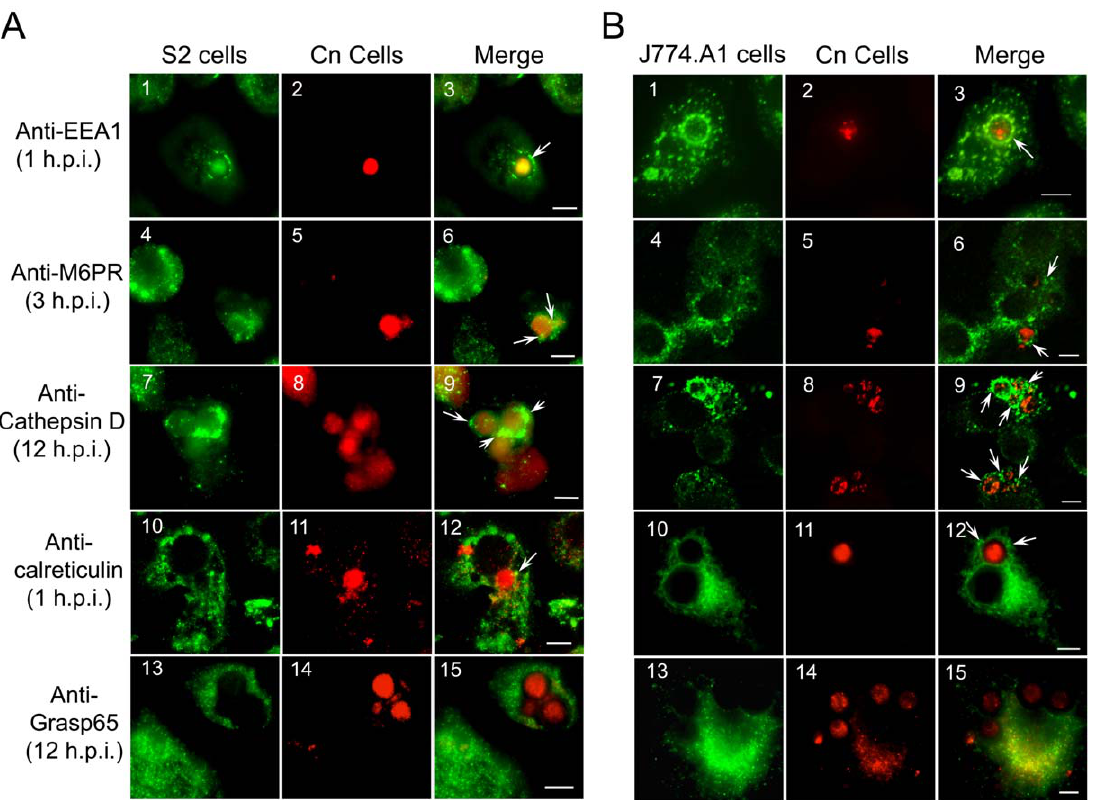
Figure 3. Cryptococcusneoformans intracellular trafficking in Drosophila S2. ( A ) and J774.A1 ( B ) cells. Host cells were seeded on 12-mm coverslips, placed on the bottom of 24-well plates and then infected with AI100-dsRed. The infected cells were washed three times with 1 6 PBS at 3 h.p.i., and fresh medium supplemented with 20 m g/ml fluconazole was added to each well containing infected host cells. The infected cells were then continuously incubated at 28 u C (S2 cells) or 37 u C, 5% CO 2 (J774.A1 cells). At the indicated time points, the infected cells were fixed and stained for analysis by immunofluorescence microscopy using antibodies directed against the indicated proteins. In Panels A and B , the localizations of the early endosome marker EEA1 (1), late endosome marker M6PR (4), lysosome marker cathepsin D (7), endoplasmic reticulum (ER) marker calreticulin (10) and Golgi marker Grasp65 (13) in host cells are shown in green. Internalized or replicative Cn cells are shown in red (2, 5, 8, 11, 14). Cn cells in vacuoles that are surrounded by EEA1 (3), decorated with antibodies directed against the late endosome marker M6PR (6) or the lysosome marker cathepsin D (9), or surrounded by calreticulin (12) are shown in the merged images (white arrows). Tight association between Cn and Grasp65 was not observed at the indicated time point (15). Representative images from a single representative experiment are shown. At least three independent experiments were performed and each experiment gave similar results. Scale bars indicate 5 m M. Cn (Table S1) were compared in J774.A1 and S2 cells. These